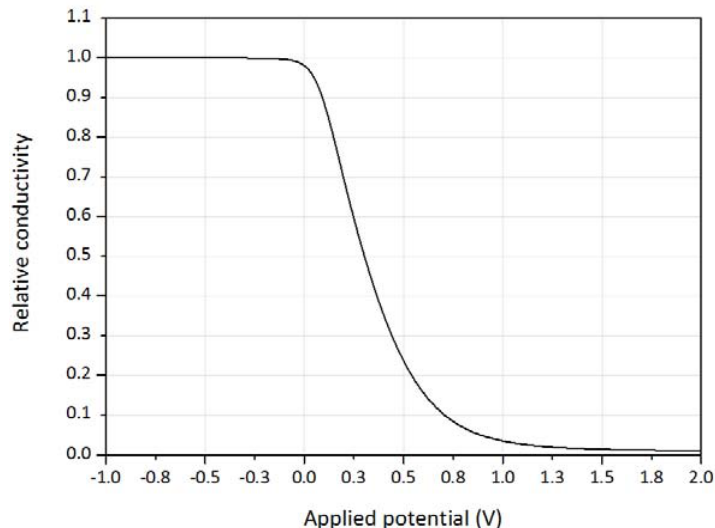
Figure 6. Calculated gate-source voltage dependent relative conductivity of PEDOT:PSS, obtained by integrating the data in Figure 2f.